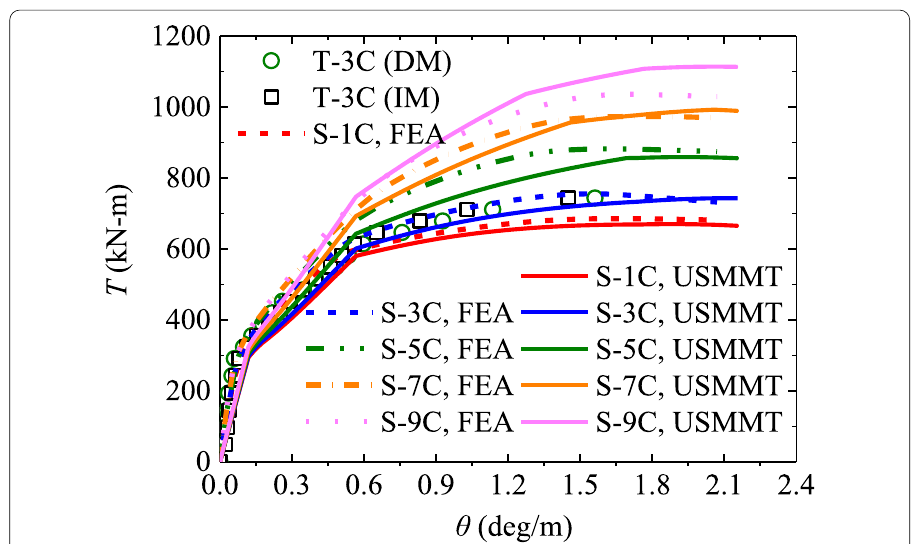
Fig. 9 Comparisons of torque-twist curves between the FEA results and the calculated results from the